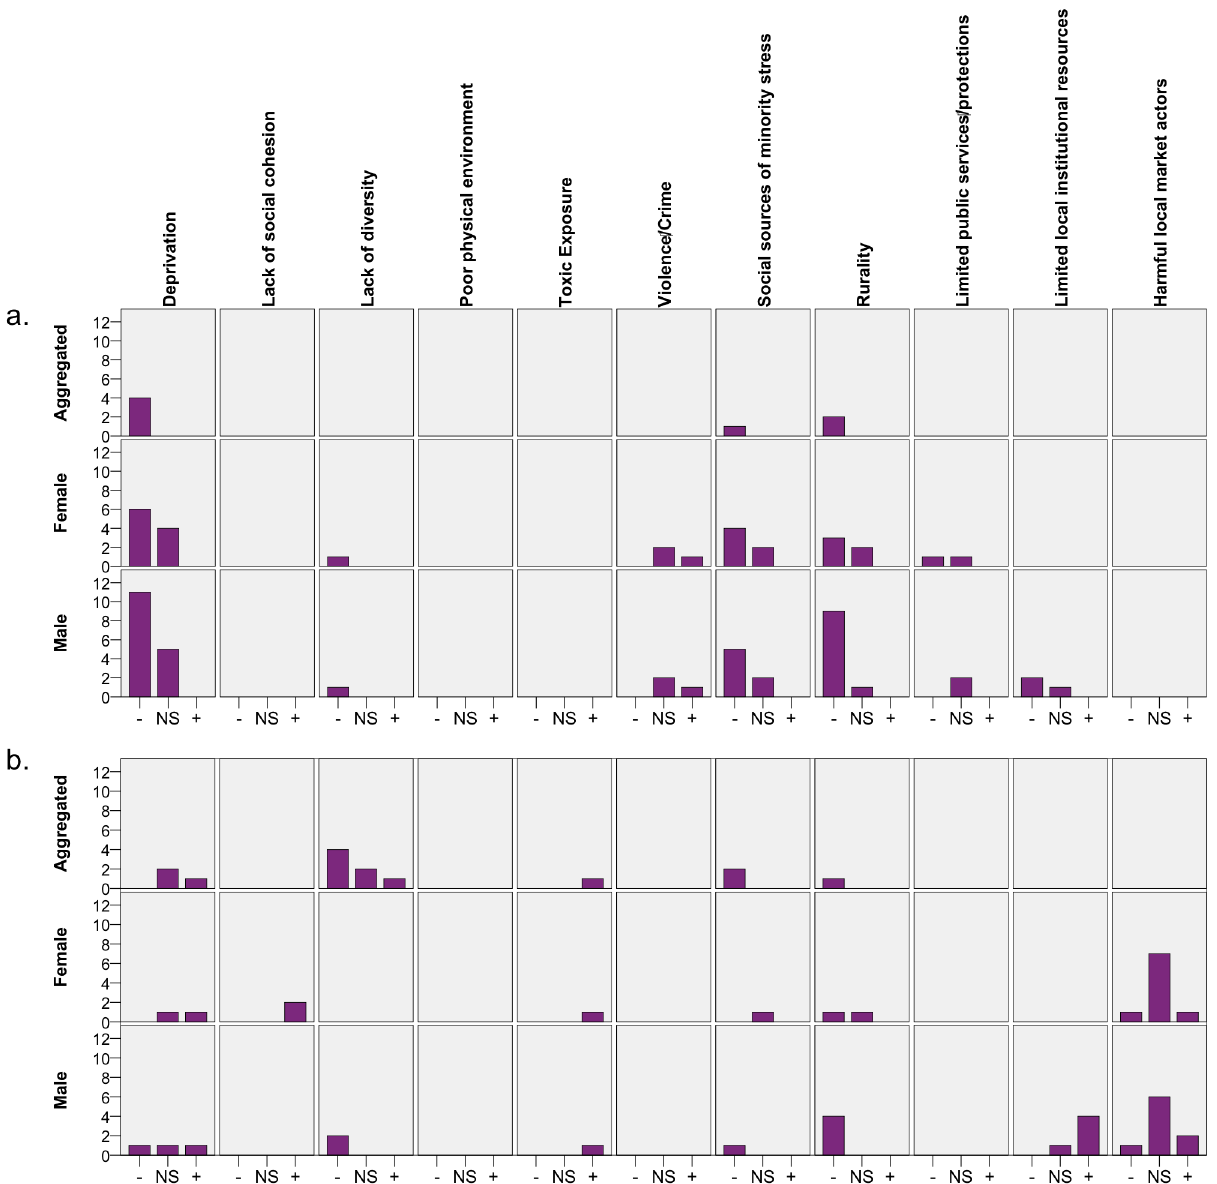
Fig 2. Harvest plot (count) of unadjusted relationship between sexual minority concentration and (a) regional area unit characteristics and (b) neighborhood area unit characteristics, by gender, n = 132 results from n = 36 records.